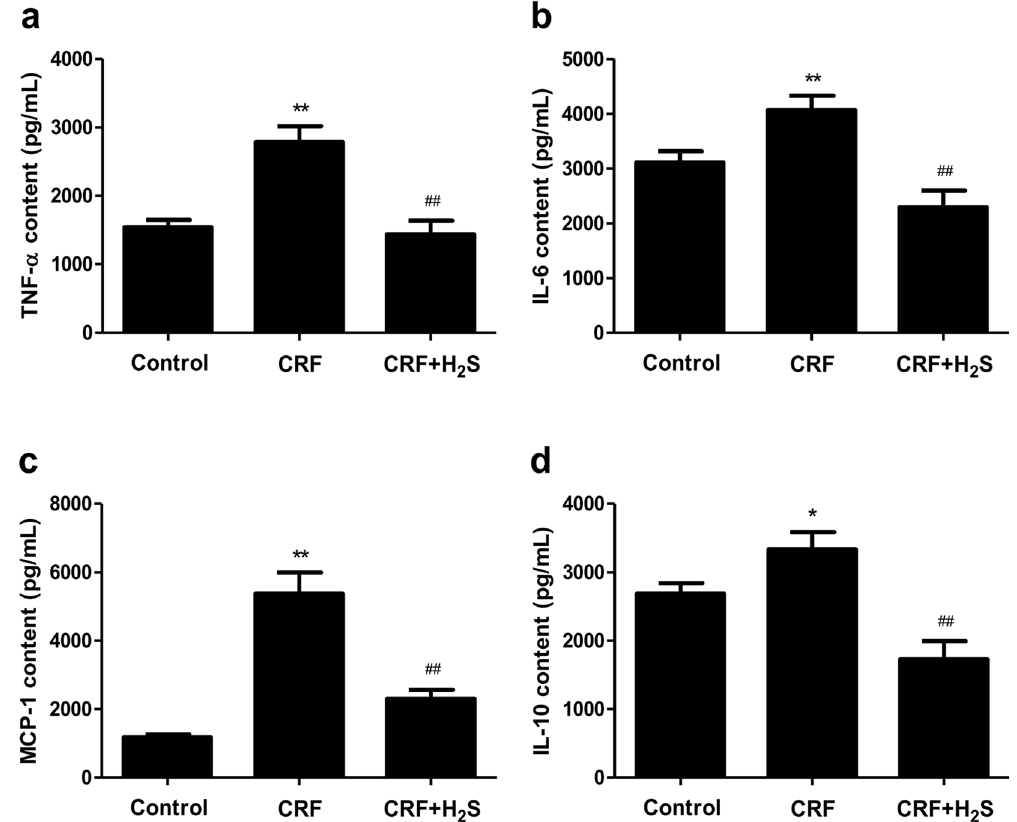
Figure 9. Effects of H 2 S on the cytokine levels in the kidney of CRF rats were assayed using ELISA techniques. The expression levels of TNF- α ( a ), IL-6 ( b ), MCP-1 ( c ), and IL-10 ( d ) were measured. Values were presented as mean ± SEM (n = 8); * P < 0.05, ** P < 0.01 compared with the control group; ## P < 0.01 compared with the CRF